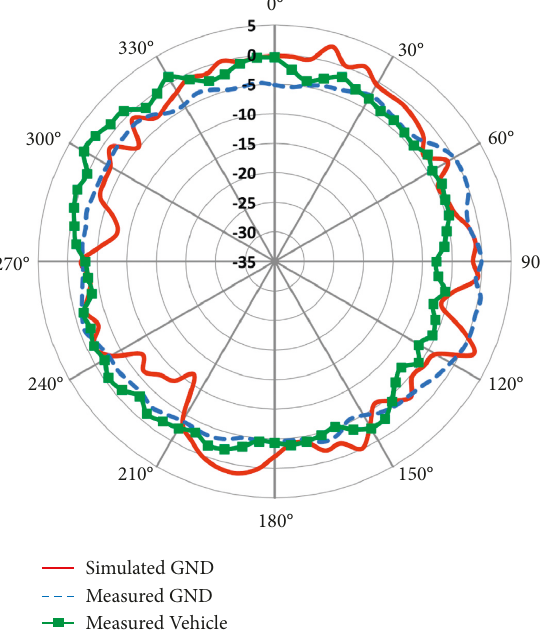
Figure 14: Antenna V2X radiation pattern simulated on ground plane and measured on ground plane and a vehicle at 90 ° elevation angle at 5900MHz (0 ° is the direction of the front of the vehicle).